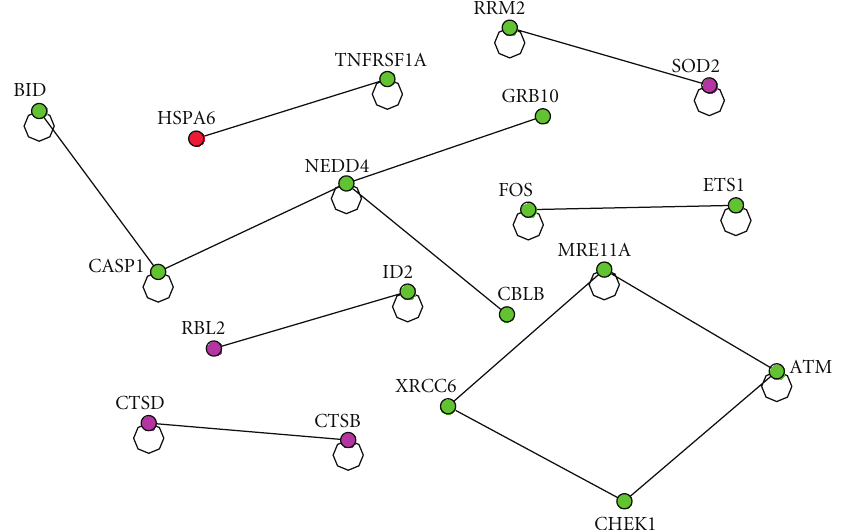
Figure 5: The interaction between the top 14 up regulated genes from Table 1 with the set of important genes based on pathway (Table 4). The red one represents the gene from Table 1. The green colored ones are down regulated and the red and purple ones are up regulated.